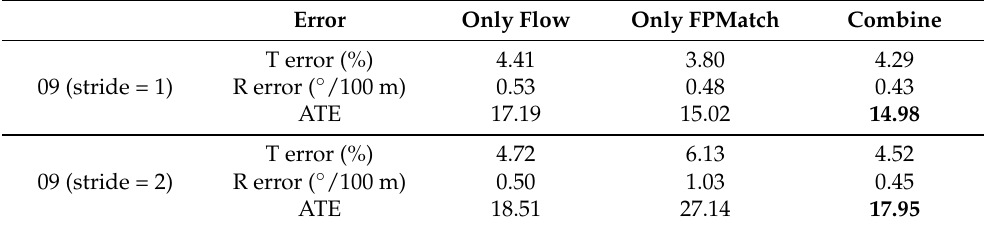
Figure 10. The upper image shows the estimated trajectories of a medium-amplitude-motion scene (stride = 3). The lower image shows the results from a large-amplitude-motion scene (stride = 4) in sequence 10 of the KITTI dataset Table 6. Ablation Study. “Only Flow” means only FlowNet and the principle of forward–backward flow consistency was used to recover the camera pose. “Only FPMatch” means SURF and FlANN were used to recover the camera pose. “Combine” means the combination of the two approaches was used to recover camera